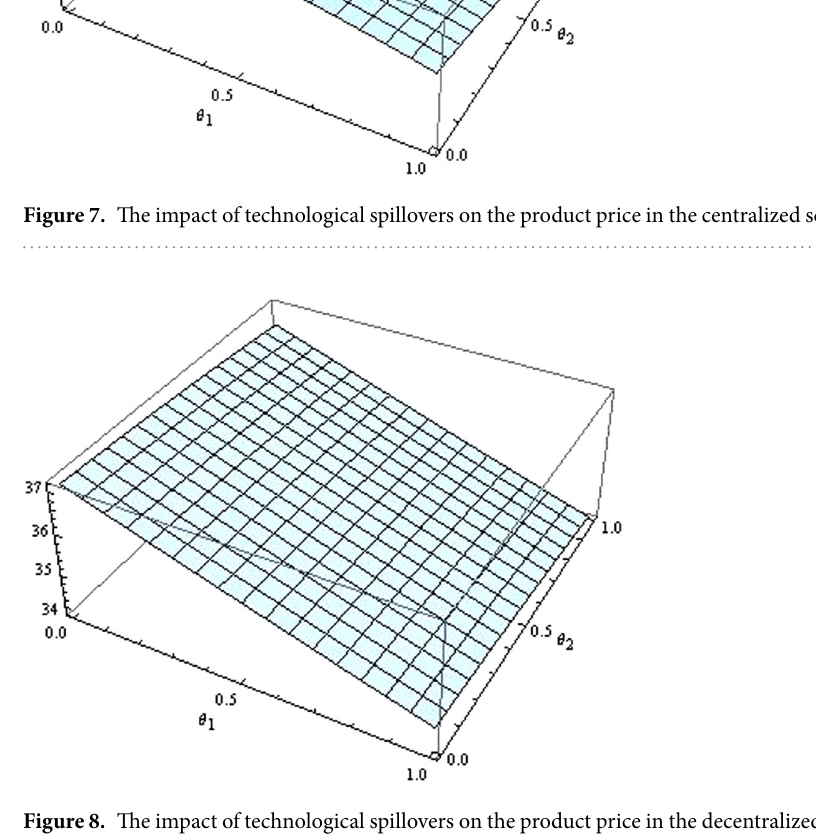
Figure 8. The impact of technological spillovers on the product price in the decentralized